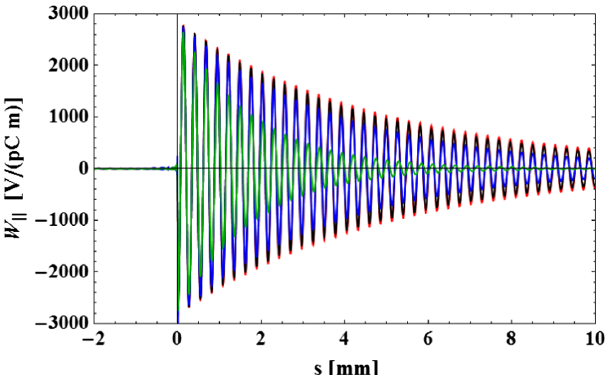
FIG. 12. Wake functions ð ε 0 1 ¼ 10 Þ for the cases ε 00 1 ¼ 0 (red line), 0.1 (black line), 0.5 (blue line), and 3 (green line); a ¼ 2 mm and d ¼ 2 μ m. main resonant frequency is in the subterahertz region (Fig. 2), while with d ¼ 2 μ m it reaches to terahertz frequencies (Fig. 10).